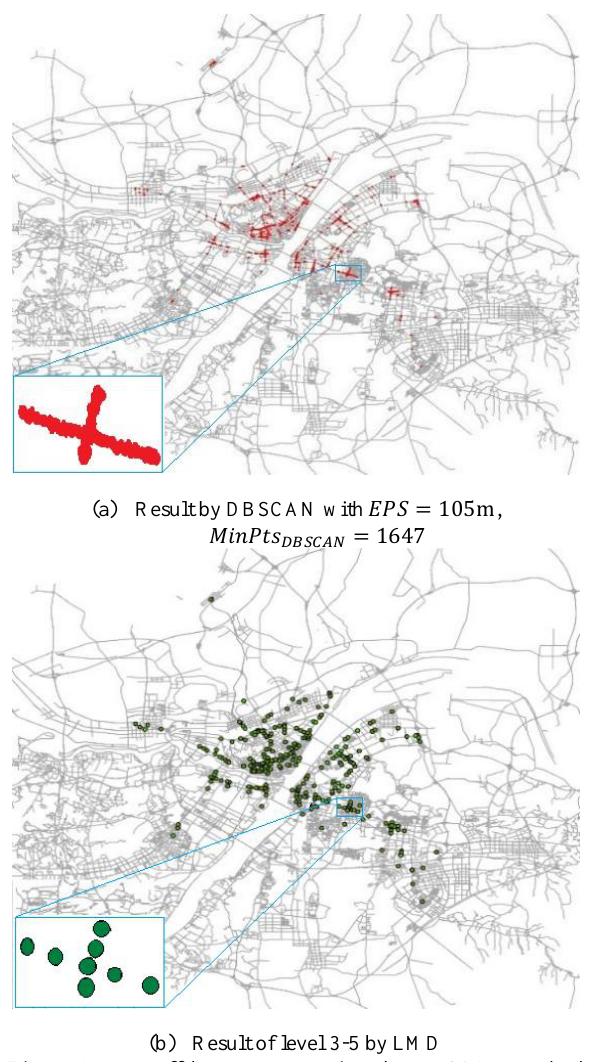
Figure 4. Drop-off hotspots extractions by DBSCAN method and LMD method. (Inset) Zoom-in to one of clusters.